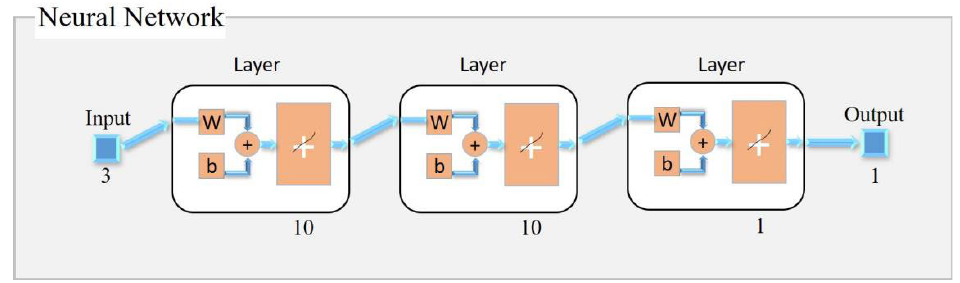
Figure 9. BP neural network structure.